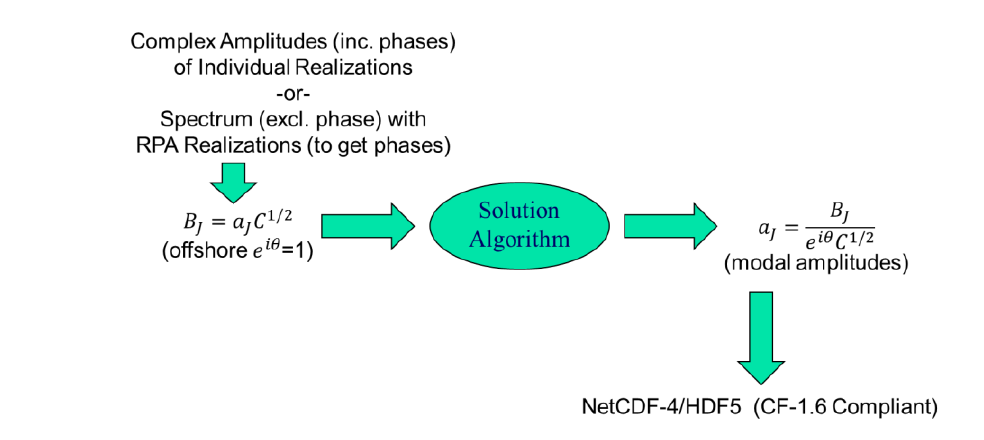
Figure 3. Model input and output.